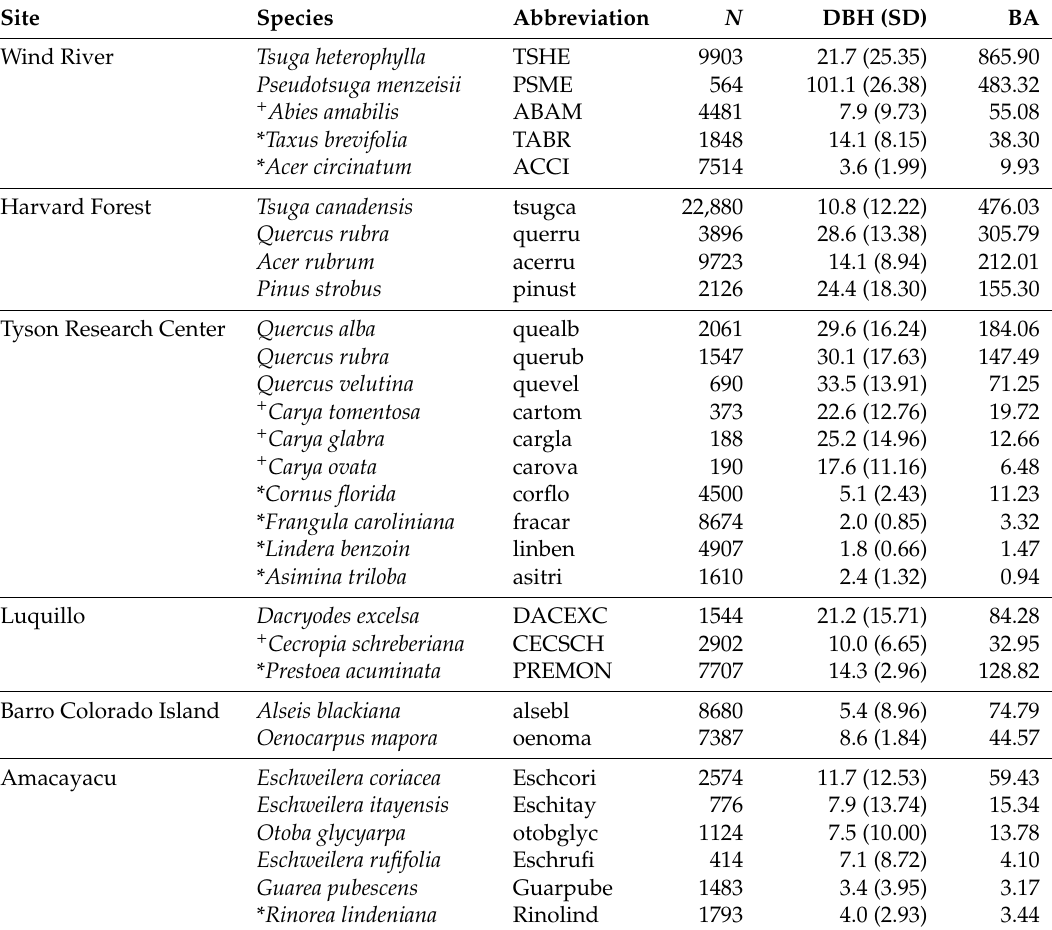
Table 1. List of focal canopy tree and understory species identified at the six sites using graphic visualizations (Figures 4 and 5), and additional species included following discussions with site PIs. Sites are ordered top-to-bottom from the northernmost temperate to equatorial, and species within sites are ordered by basal area within canopy and understory species. Abbreviations are those used at each site as species codes, and which are used in the legends and labeling of Figures 2–5. N is the total number of live individuals of each species in each forest dynamics plot; DBH is the average diameter (in cm) measured at 1.3 m aboveground (standard deviation in parentheses) for all individuals of a given species in each forest dynamics plot; and BA is the total basal area (m 2 ) of the species in each ForestGEO